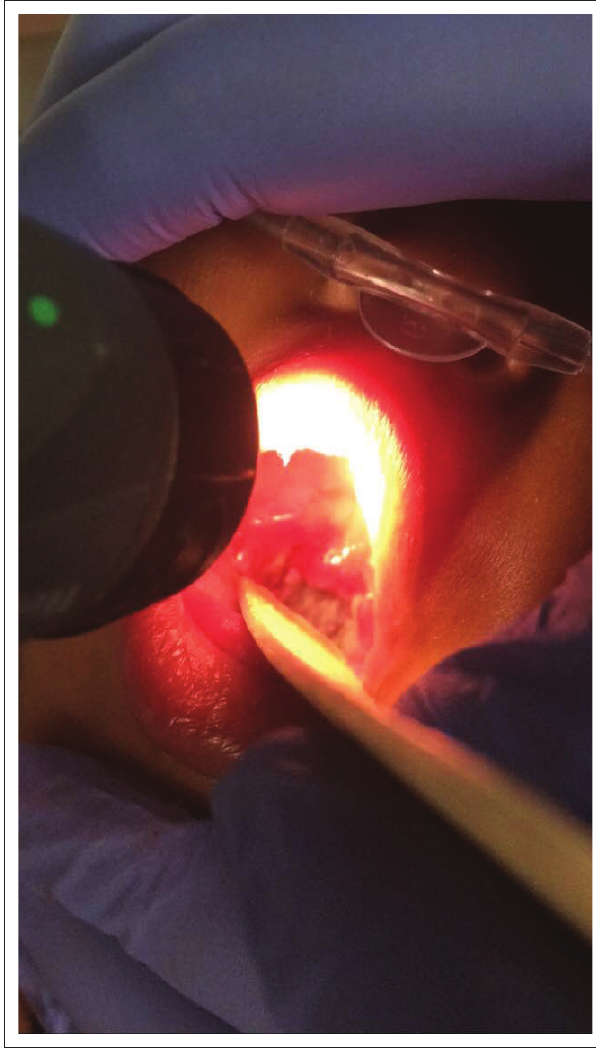
FIGURE 1: White membrane adherent to the pharynx noted on oropharyngeal examination on presentation in a 14-month-old incompletely vaccinated infant with respiratory